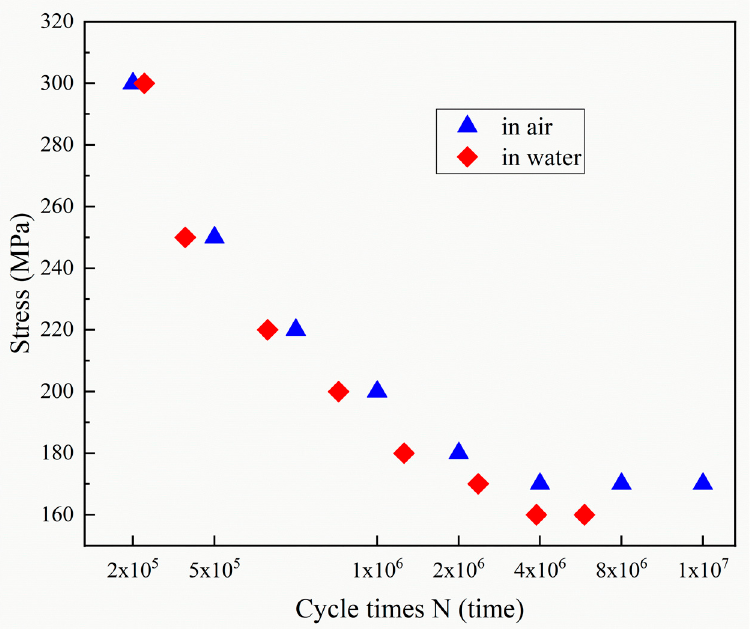
Figure 4. S-N curves where the red scatters represent fatigue life in the water environment and the blue ones represent that in air condition.